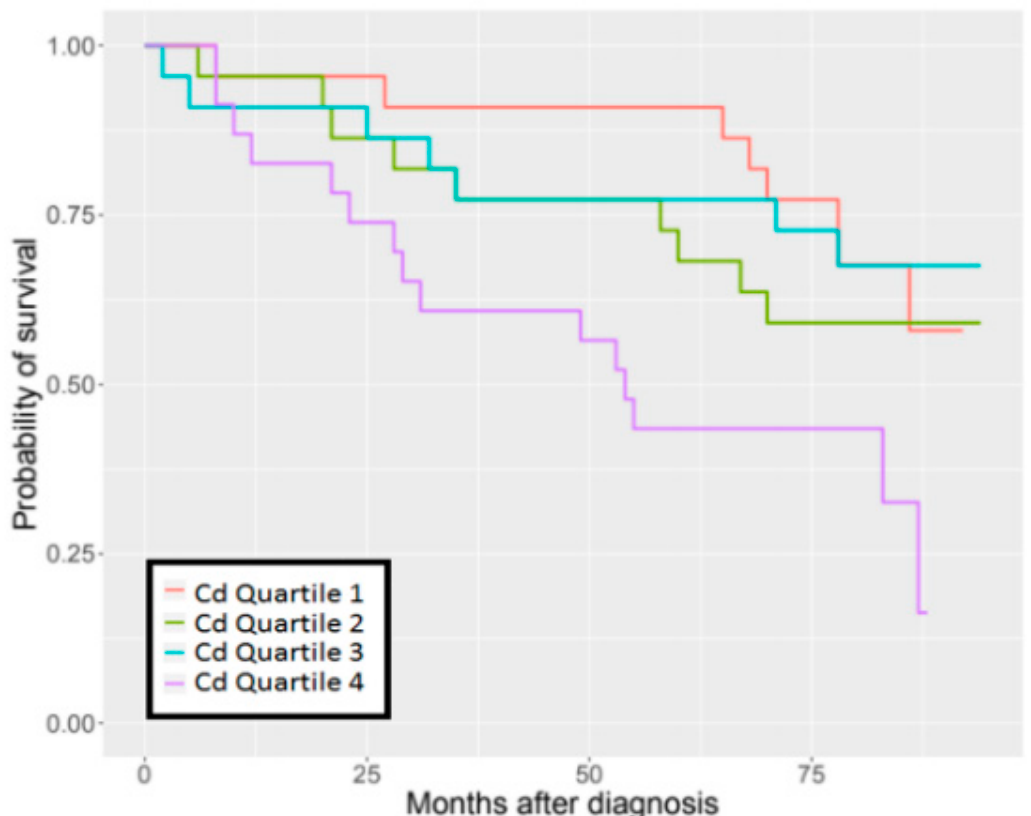
Figure 1. 96-months overall survival by Cd levels in stage IA of lung cancer. The cut-off point for Cd concentration for patients with stage IA disease associated with improved survival was 1.47 µg/L (Figure 2).